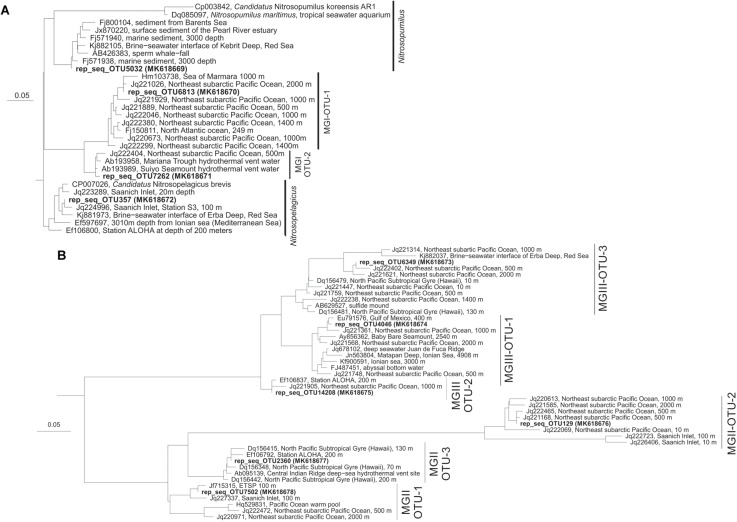
Phylogenetic trees showing the representative sequences (rep_seq, obtained by pick_rep_set.py in qiime of the OTUs picked by Usearch as specified in the material and methods. NCBI accession numbers between parentheses) present in the ETSP of the four OTUs of Thaumarchaeota (A), and the three OTUs of MGII and MGIII archaea (B) in relation to closely related sequences. Scale bar indicates estimated sequence divergence (i.e., 5%).